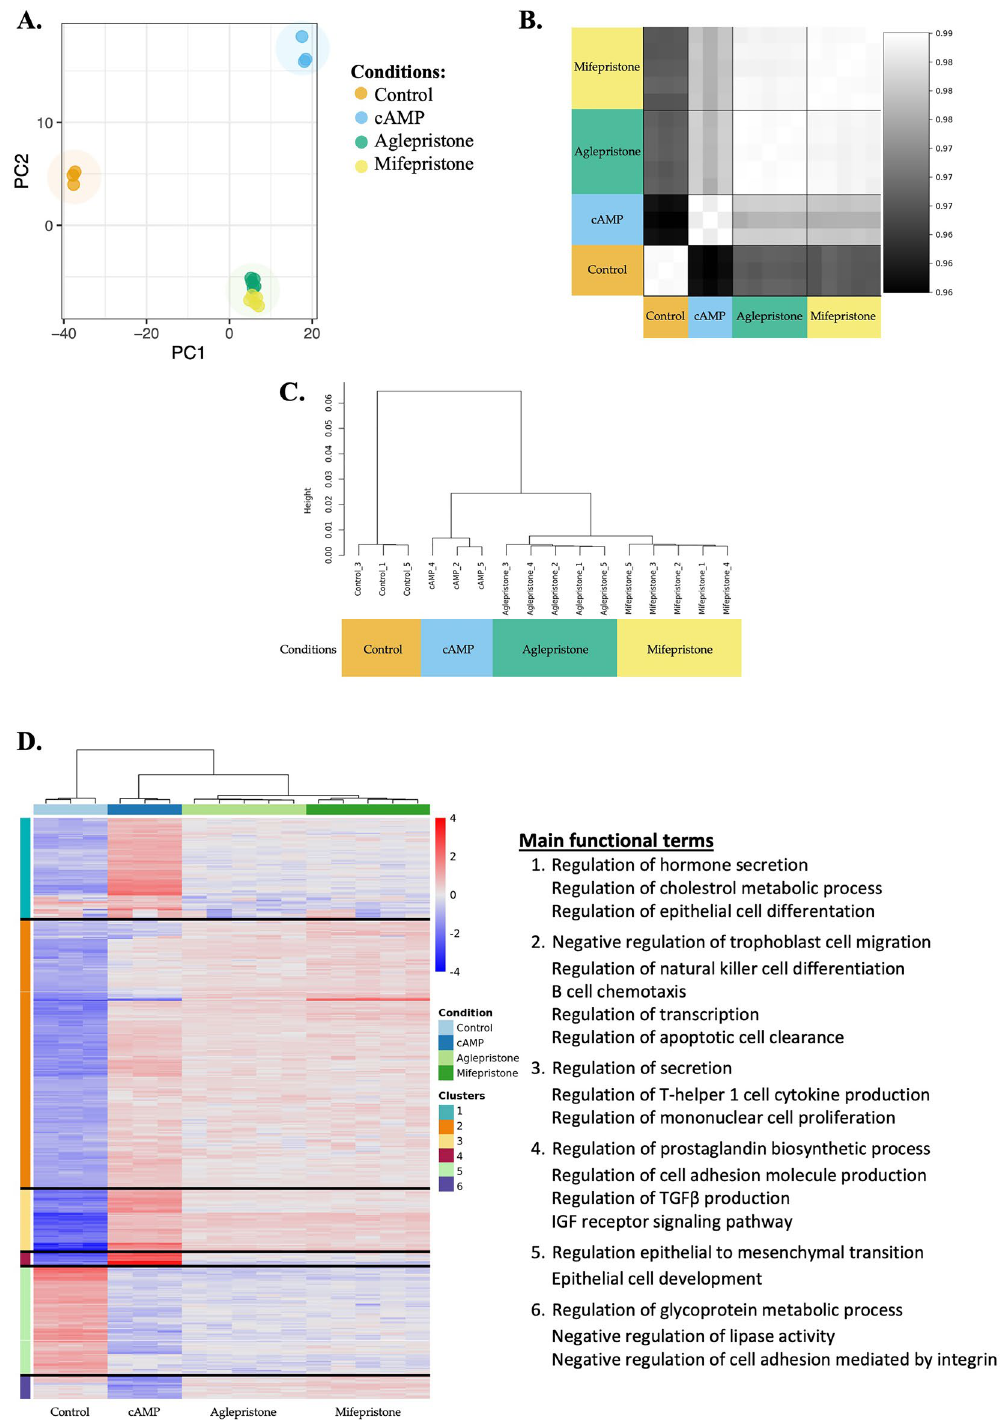
Figure 1. Exploratory analysis of distribution and homogeneity of samples after removal of outliers containing the 2000 genes that varied the most among all samples. ( A ) In the principal component analysis (PCA) plot of all samples, a clear separation can be observed between different treatment conditions, i.e., control, cAMP- treated and antigestagen-treated. ( B ) Samples correlation matrix shows a high homogeneity between the samples belonging to each experimental group, associated with a ( C ) clear clustering of samples from each group. ( D ) Heatmap of 2,000 genes varying the most between all samples. Colors red to blue indicate a gradient of high to low expression of each gene related to its average expression. Gene ontologies (GOs) obtained with Enrichr are presented for each cluster or genes. Clear separation of transcriptional effects was observed, in particular between control, cAMP and antigestagen-treated groups. All plots and diagrams were generated by the CountQC app available in the SUSHI